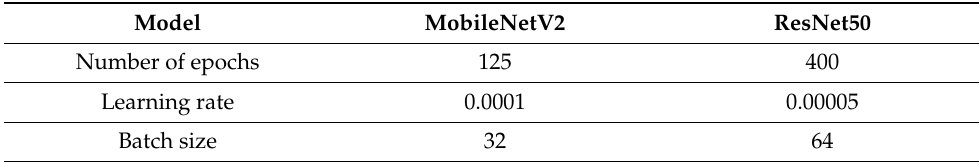
Table 1. Deep Learning models hyperparameters.